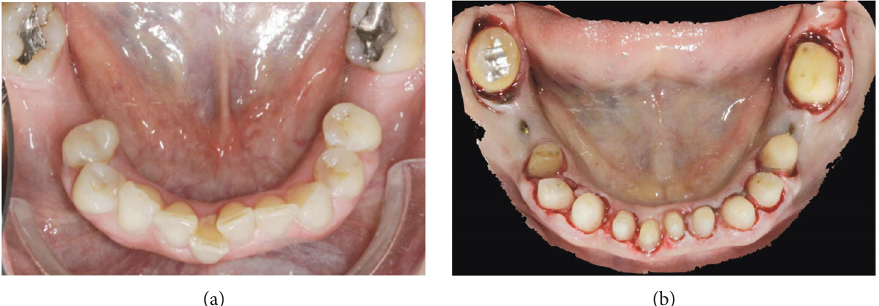
Figure 12: The mandibular arch showing the right central incisor and the second molars before the prosthetic preparation (a) and realignment after the POA (b).